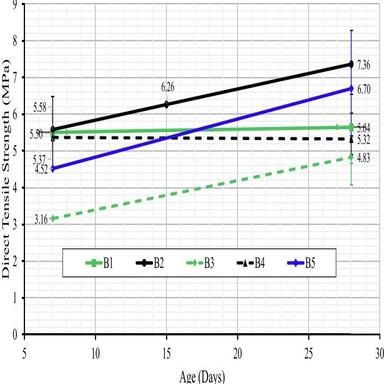
Direct tensile strength versus time of the NP-UHPC mixes.